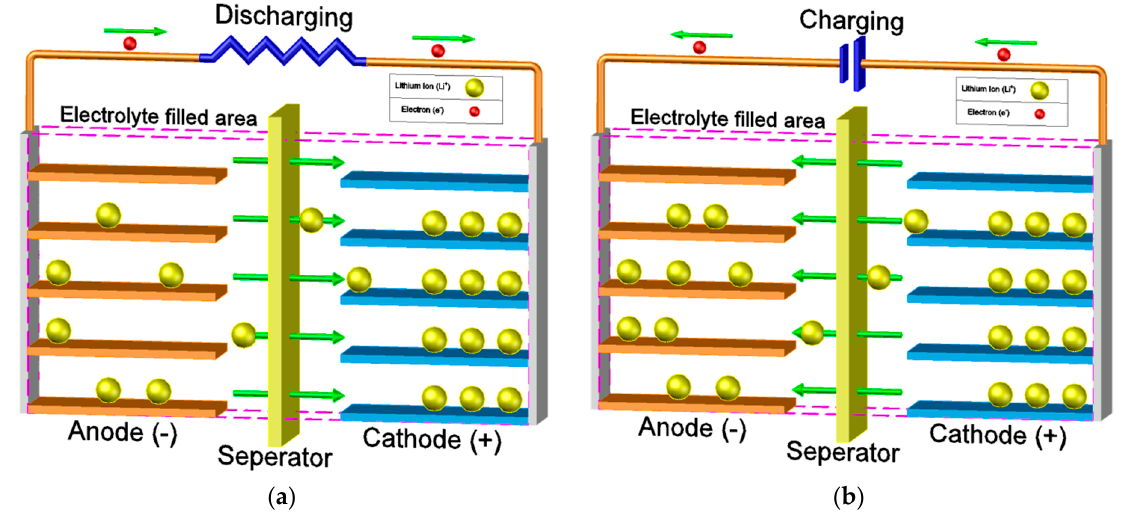
Figure 1. A schematic presentation of the discharging ( a ) and charging ( b ) processes in lithium − ion batteries.